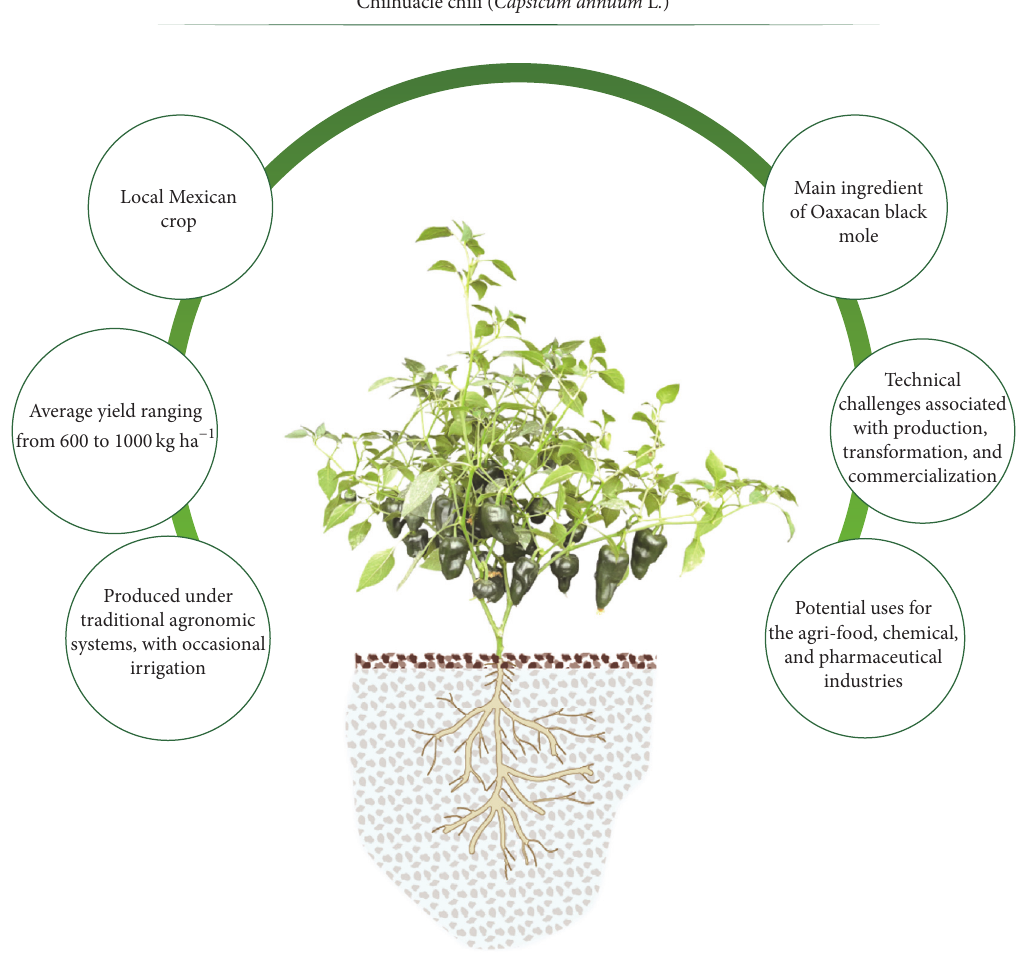
Figure 1: Summary of chilhuacle chili production, yield, and potential uses.